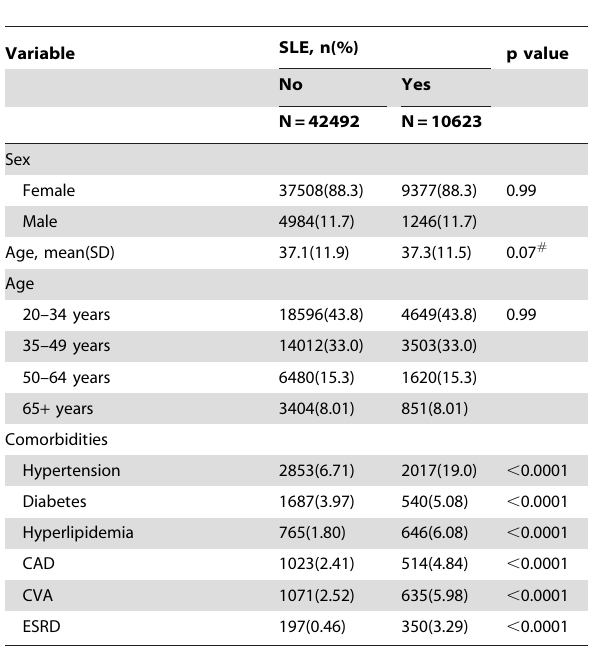
Table 1. Demographic characteristics and comorbidities in patients with and without systemic lupus